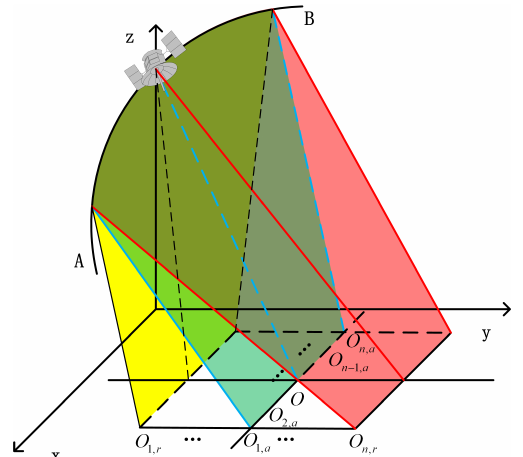
Figure 10. 2D spatially variant geometry model of GEO SAR